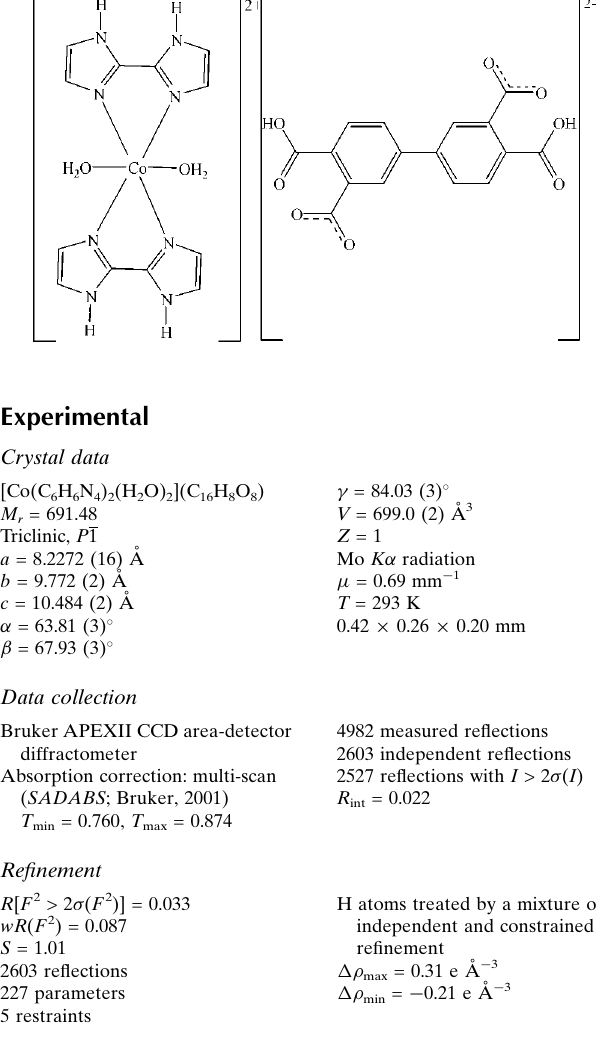
Selected geometric parameters (A ˚ , (cid:2) ).